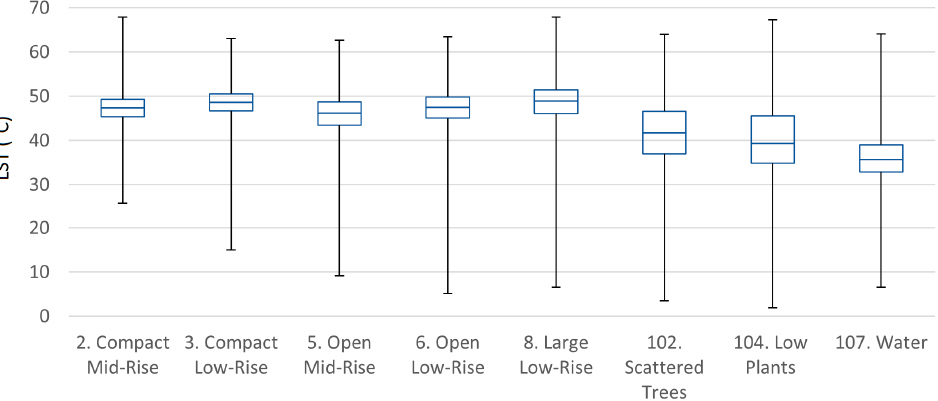
Figure 9. Boxplots of the LST per LCZ class. Each box is delimited by the first and third quartiles of the distribution. The median is represented as a horizontal line inside each box. The two lines extending from the box (whiskers) describe the distribution variability outside the quartiles.